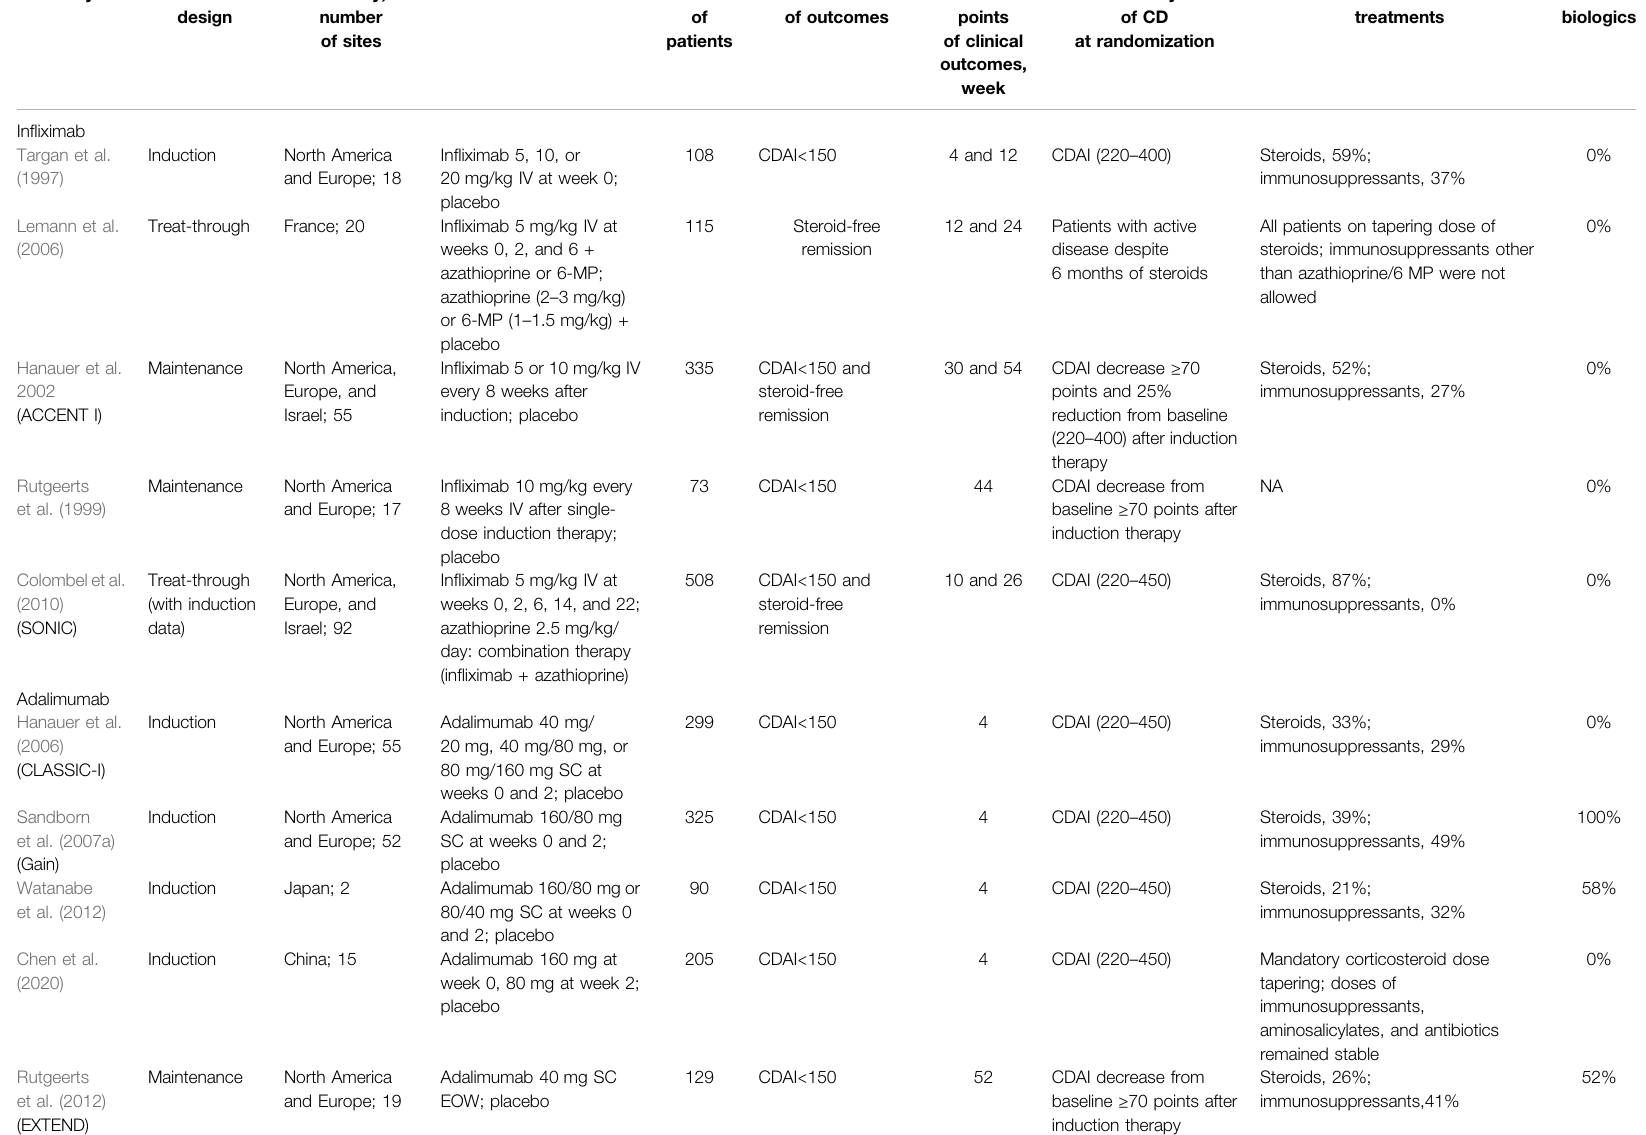
TABLE 1 | Characteristics of studies included in the